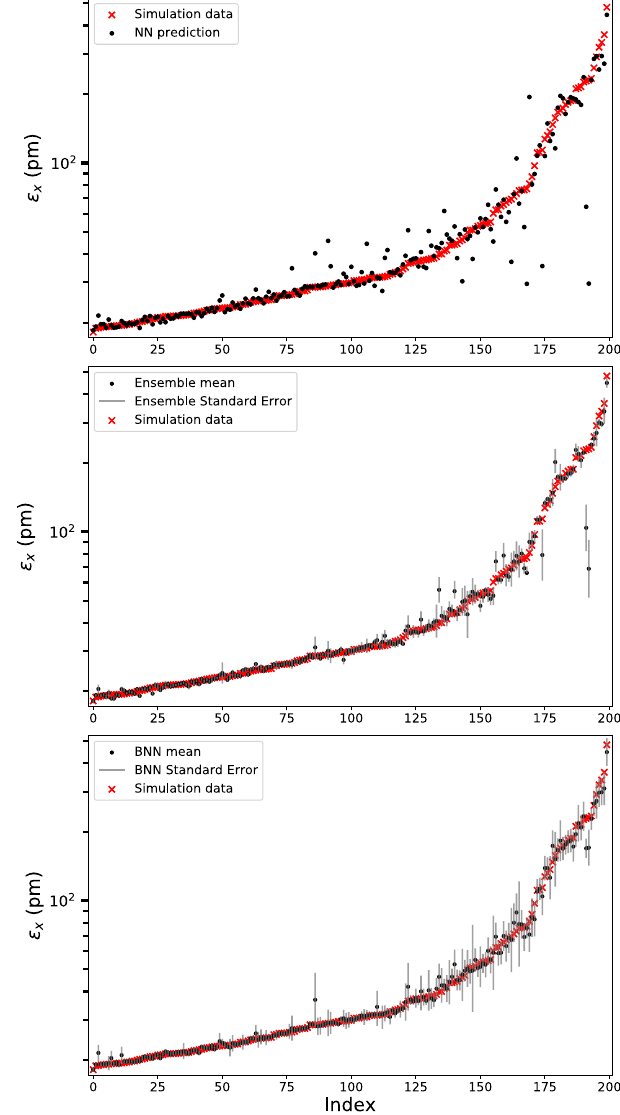
FIG. 6. Comparison of (a) Deterministic neural network, (b) Bootstrapped ensembles, (c) Bayesian neural network pre- dictions for the x -emittance for the LCLS electron